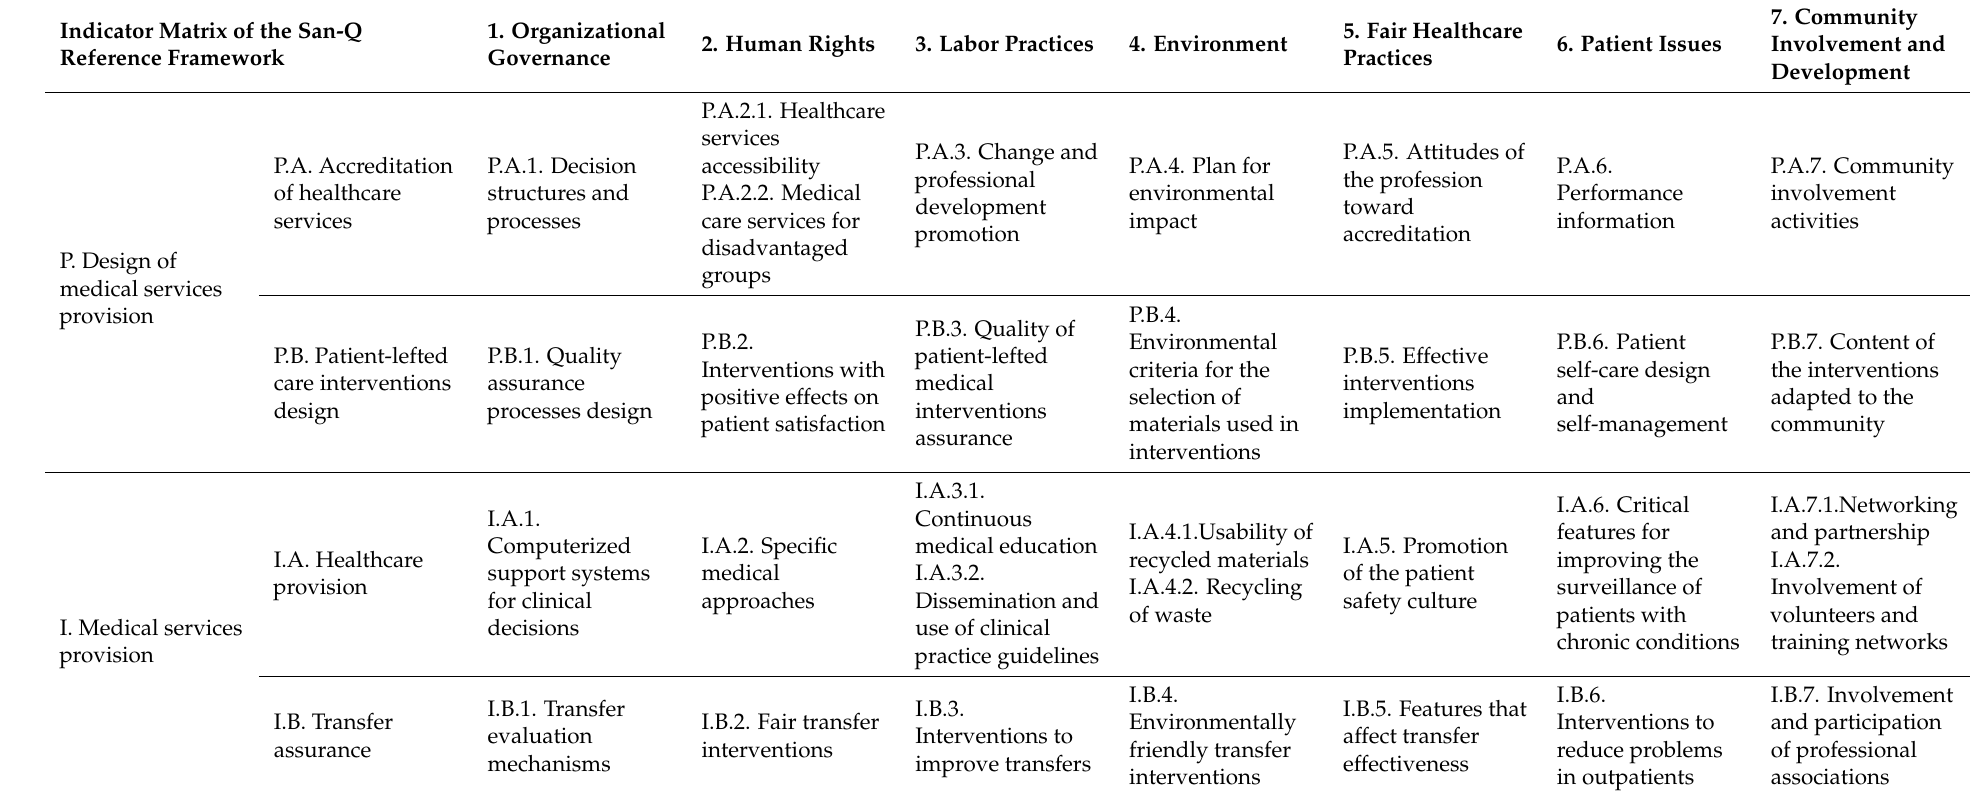
Table 1. Indicator matrix of the San-Q sustainable development